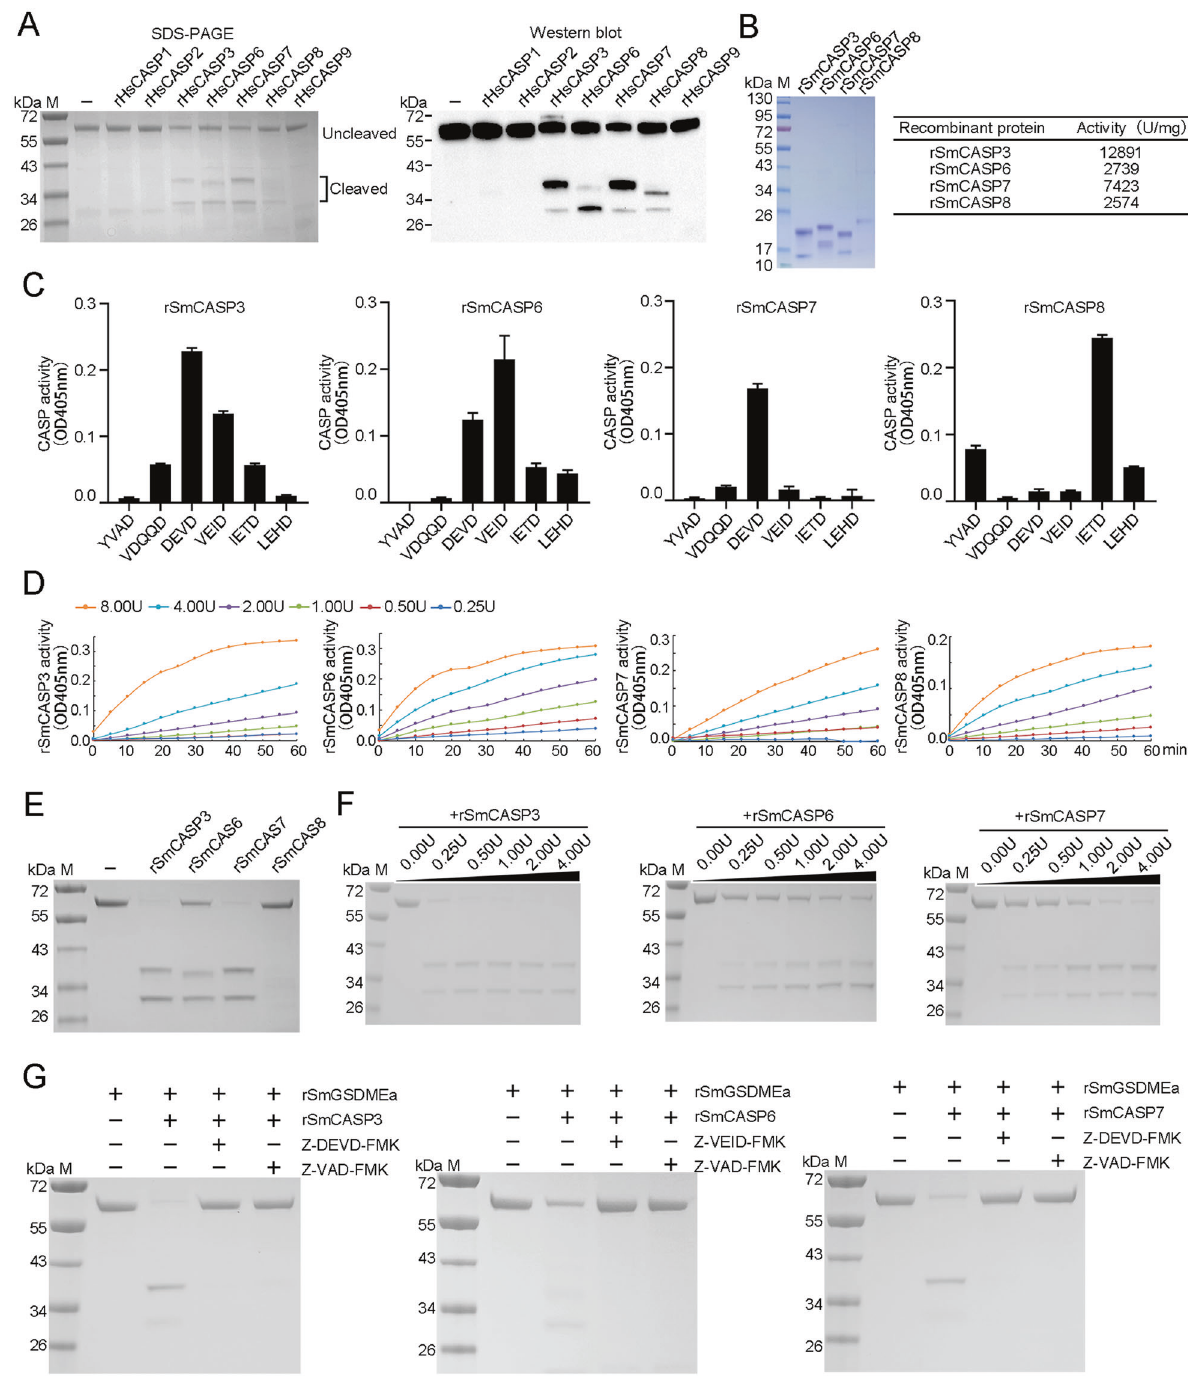
Fig. 2 rSmGSDMEa is cleaved by CASP3/6/7. A rSmGSDMEa was treated with rHsCASP1, 2, 3, 6, 7, 8 or 9 and then analyzed by SDS-PAGE (left panel). The cleaved fragments were immunoblotted with anti-His tag antibody (right panel). B SDS-PAGE analysis (left) and activity (right) of rSmCASP3, 6, 7, and 8. C The proteolytic speci fi cities of rSmCASP3, 6, 7 and 8 were determined by treatment with different colorimetric substrates and measuring the released ρ NA. The data are expressed as the means ± SD, n = 3. D rSmCASP3, 6, 7, 8 at different doses (0.25 to 8 U) were incubated with their respective colorimetric substrates, and the released ρ NA was measured. E rSmGSDMEa was treated with rSmCASP3, 6, 7, or 8, and then analyzed by SDS-PAGE. F rSmGSDMEa was treated with different units of rSmCASP3, 6 or 7, and then subjected to SDS-PAGE. G The cleavage of rSmGSDMEa by rSmCASP3, 6, or 7 were determined in the absence or presence of CASP inhibitors Z-VAD-FMK, Z-DEVD-FMK or Z-VEID-FMK. cleaved SmGSDMEa-CT fragment in co-transfected cells (Fig. 5D), SmCASP3, SmCASP7, and SmGSDMEa expression alone had no implying activation of SmGSDMEa by SmCASP3/7. Consistently, the apparent effect on cellular morphology and viability. However, co- presence of the CASP3 inhibitor and pan-CASP inhibitor signi fi cantly expression of SmCASP3/7 and SmGSDMEa induced pyroptosis and inhibited pyroptosis and LDH release from the cells co-transfected massive release of LDH (Fig. 5B, C). Immunoblot detected the Cell Death and Disease (2022)